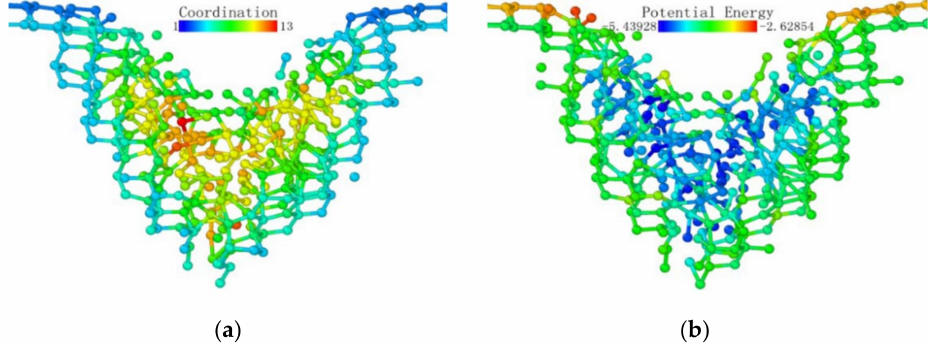
Figure 21. Atomic transient state at 1.66 nm stroke. ( a ) coordination number distribution, ( b ) potential